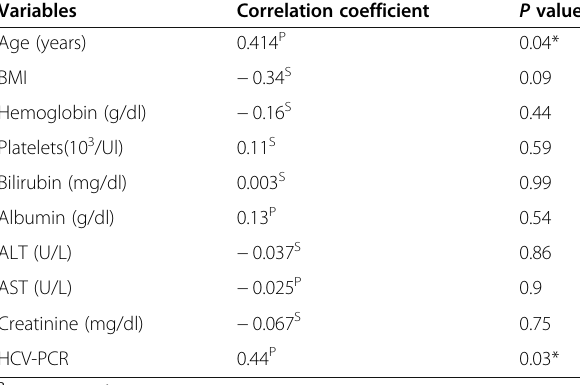
Table 4 Correlation between 3 months VEGF values and laboratory findings in HCV HCC-free patients